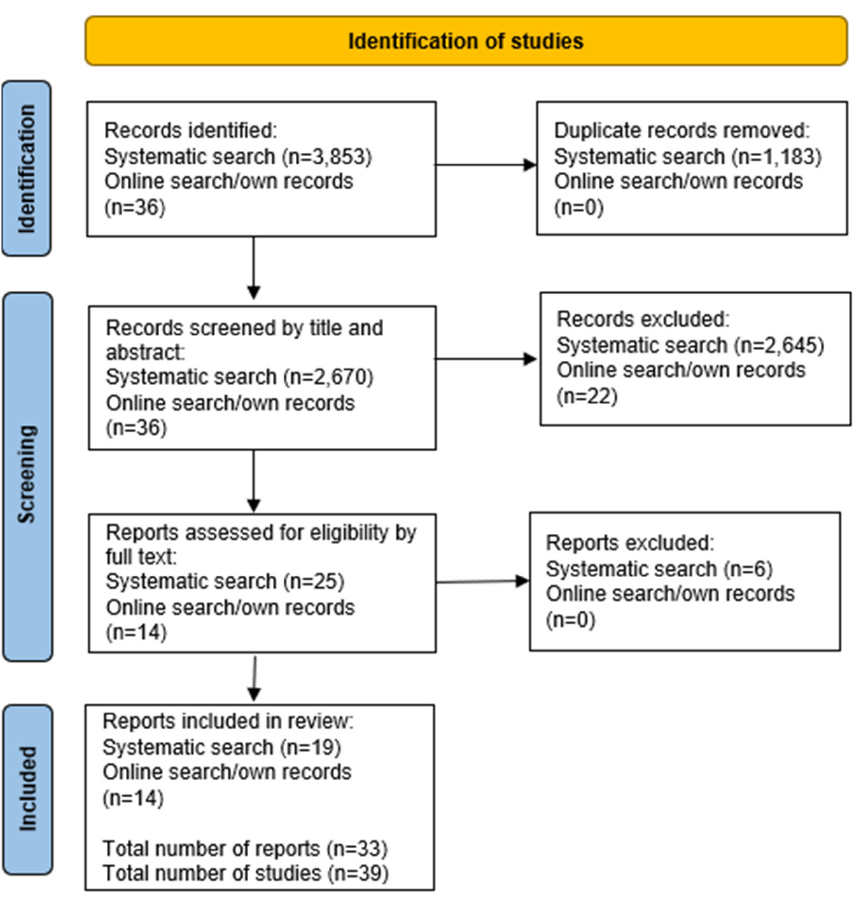
Figure 1. PRISMA flow diagram of the identification of studies.